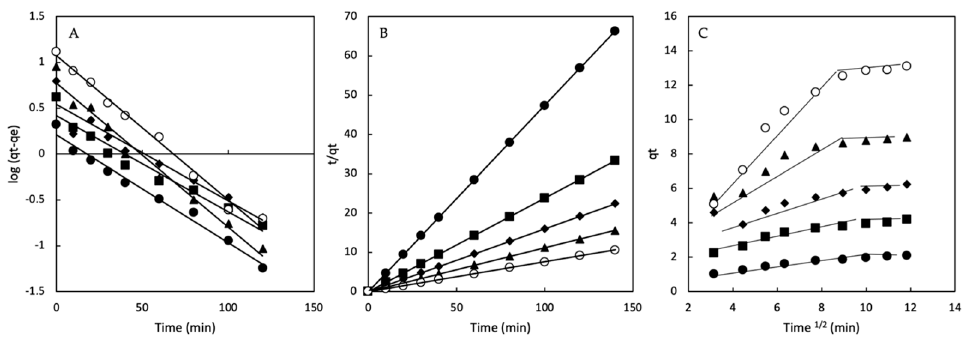
Figure 11. The kinetics analysis ( A ) pseudo-first model; ( B ) pseudo-second model; ( C ) intraparticle di ff usion model. Co: 50 ( ● ), 100 ( ■ ), 150 ( ⯁ ), 200 ( ▲ ), and 300 ( ○ ) mg/L. N = 3.